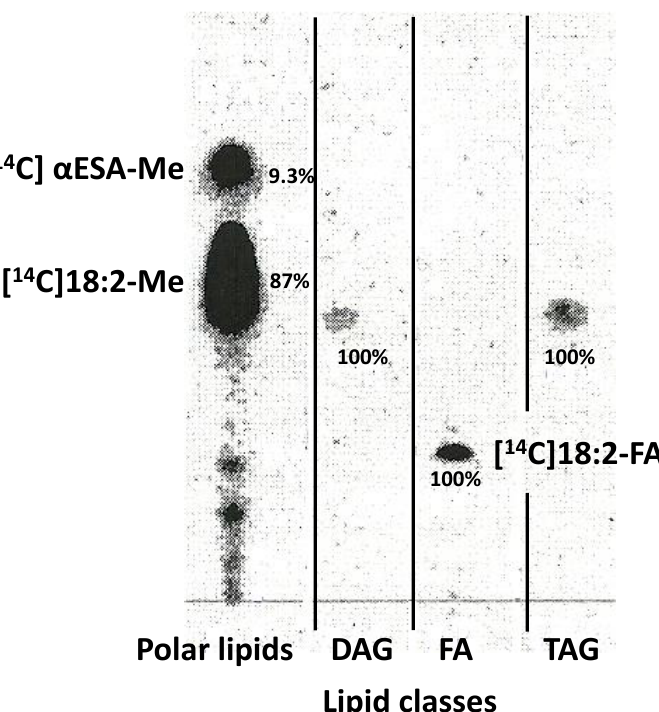
Figure 8. Distribution of [ 14 C]αESA and [ 14 C]18:2 by different lipid classes after 10 min incubation of the microsomal fraction of developing seeds of Momordica charantia with exogenous [ 14 C]18:2-CoA. X% = percentage of [ 14 C] per line (mean values from duplicates). Assay conditions: 10 nmol [ 14 C]acyl-CoA, BSA (4 mg/mL), NADH (4 mM); aliquots of microsomal fractions: 24 nmol microsomal PC.